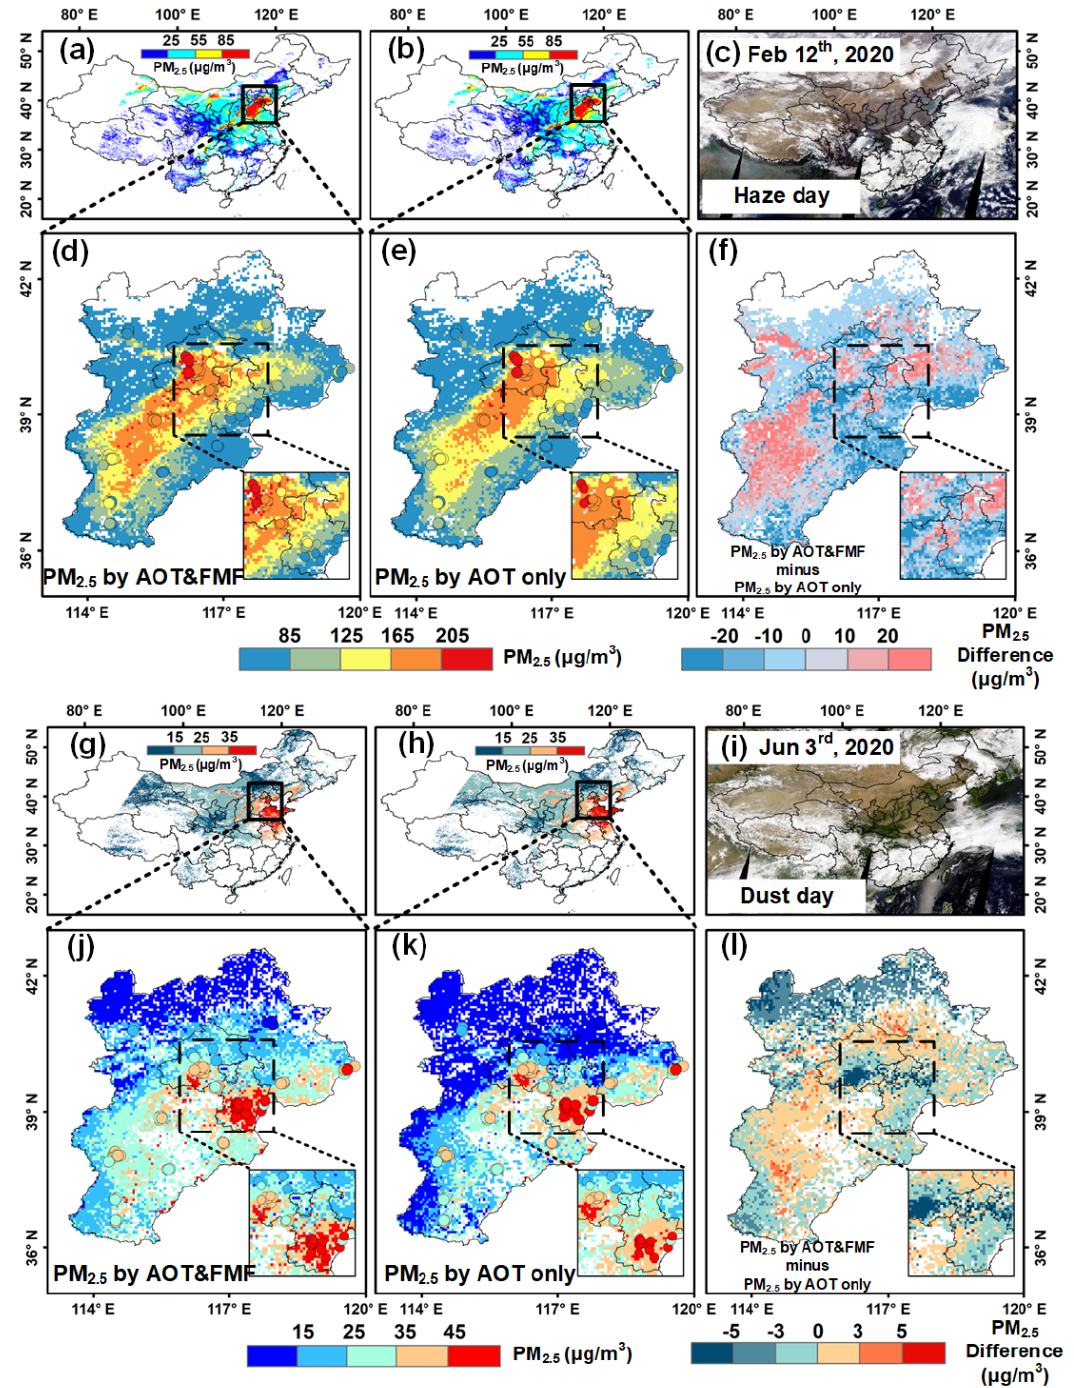
Figure 8. PM 2.5 estimation on 12 February 2020 (haze day) and on 3 June 2020 (dust day). ( a , g ) AOT&FMF-PM 2.5 in China; ( b , h ) AOT-PM 2.5 in China; ( c , i ) true color image on haze/dust day where the black line is the boundary of China; ( d , j ) AOT&FMF-PM 2.5 in Beijing-Tianjin-Hebei (BTH) region; ( e , k ) AOT-PM 2.5 in BTH region; ( f , l ) differences in PM 2.5 between AOT&FMF-PM 2.5 and AOT-PM 2.5 in BTH regions.